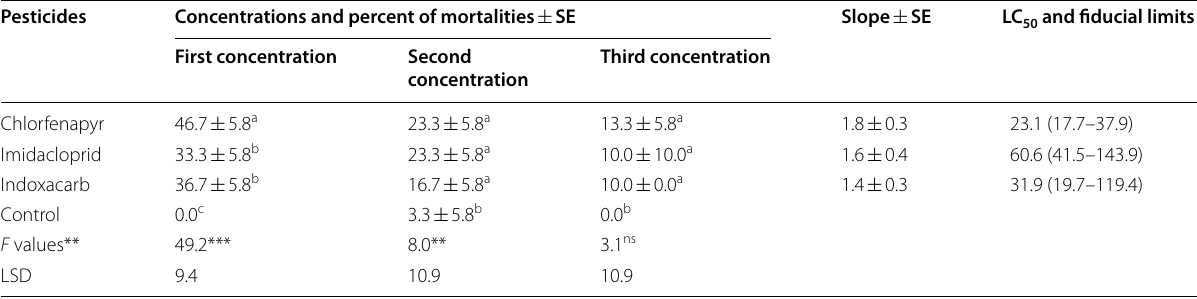
Table 3 Toxicity of some nanopesticide formulations against the chocolate banded snail, M. vermiculata Pesticides